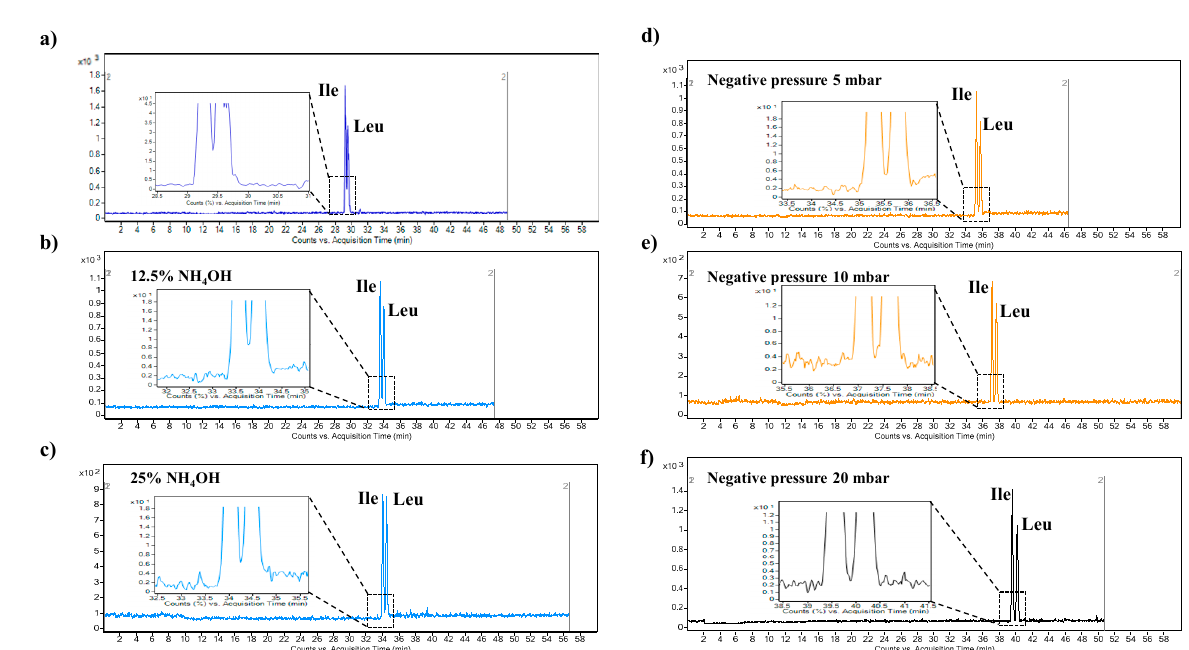
Figure 2. Effect of the NH 4 OH short plug injection before the sample injection and effect of the negative pressure application on the separation of isobaric amino acids isoleucine (Ile) and leucine (Leu). ( a ) Extracted multiple reaction monitoring (MRM) record of Ile and Leu obtained under convenient separation conditions. ( b ) Extracted MRM record of Ile and Leu obtained from the injection of a 12.5% NH 4 OH solution before the sample injection. The NH 4 OH solution was injected for 5 s. ( c ) Extracted MRM record of Ile and Leu obtained under convenient separation conditions and an injection of a 25% NH 4 OH solution before the sample injection. The NH 4 OH solution was injected for 5 s. ( d ) Extracted MRM record of Ile and Leu obtained from the injection of a 12.5% NH 4 OH solution before the sample injection, and application of negative pressure at the value 5 mbar. ( e ) Extracted MRM record of Ile and Leu obtained from the injection of a 12.5% NH 4 OH solution before the sample injection, and application of negative pressure at the value 10 mbar. ( f ) Extracted MRM record of Ile and Leu obtained from the injection of a 12.5% NH 4 OH solution before the sample injection, and application of negative pressure at the value 20 mbar. The concentration of the injected sample was 25 µ M. For details of the capillary electrophoresis-tandem mass spectrometry method, see Section 3.